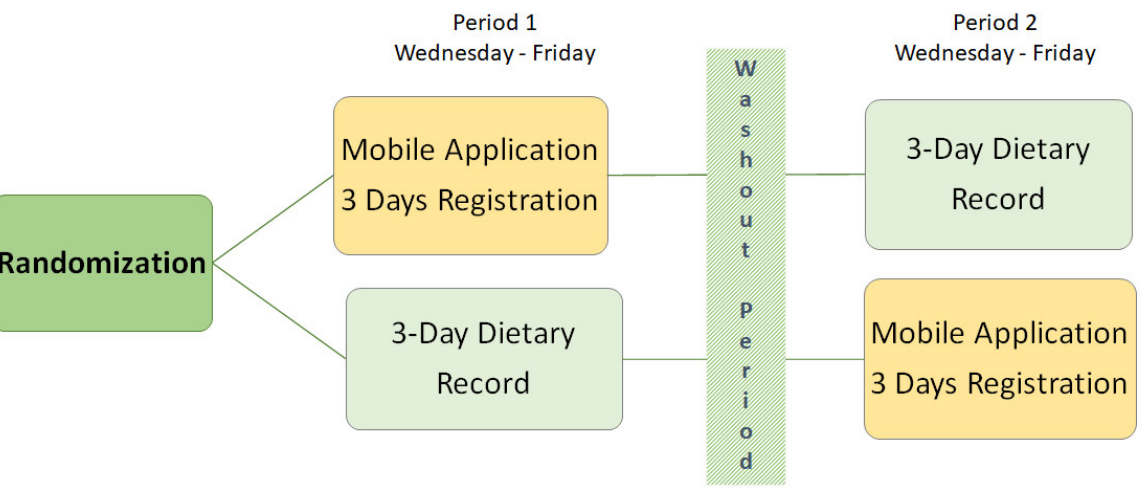
Figure 2. Flow chart of the study design.